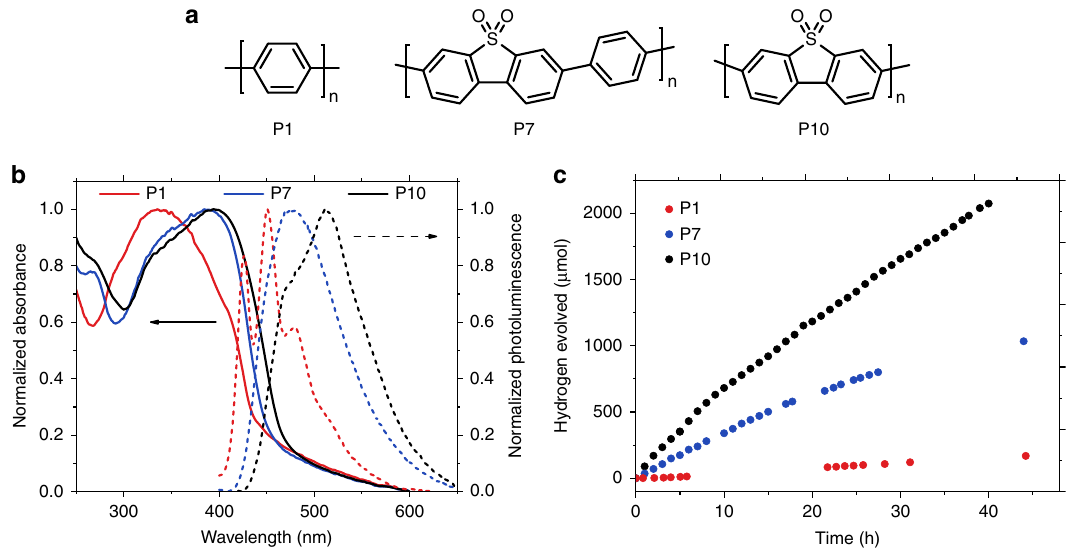
Fig. 1 Polymer structures, optical properties, and hydrogen evolution experiments. a Chemical structures of polymers P1, P7, and P10. b UV – visible absorbance spectra and photoluminescence emission spectra at 345 nm excitation, acquired in aqueous suspension. c Time course for photocatalytic hydrogen evolution under visible light illumination ( λ > 420 nm) using 25 mg photocatalyst in a 22.5 mL mixture consisting of equal volumes of H 2 O, MeOH, and TEA. A total of 2.07 mmol of hydrogen was evolved for P10, exceeding the amount of hydrogen present in P10 and therefore ruling out